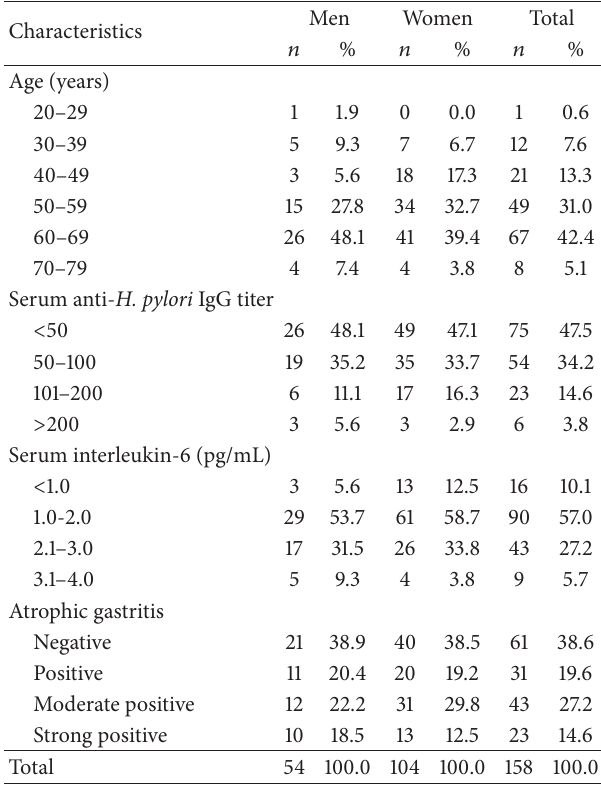
Table 1: Distribution of age, serum anti- H. pylori IgG, interleukin-6 level, and atrophic gastritis by